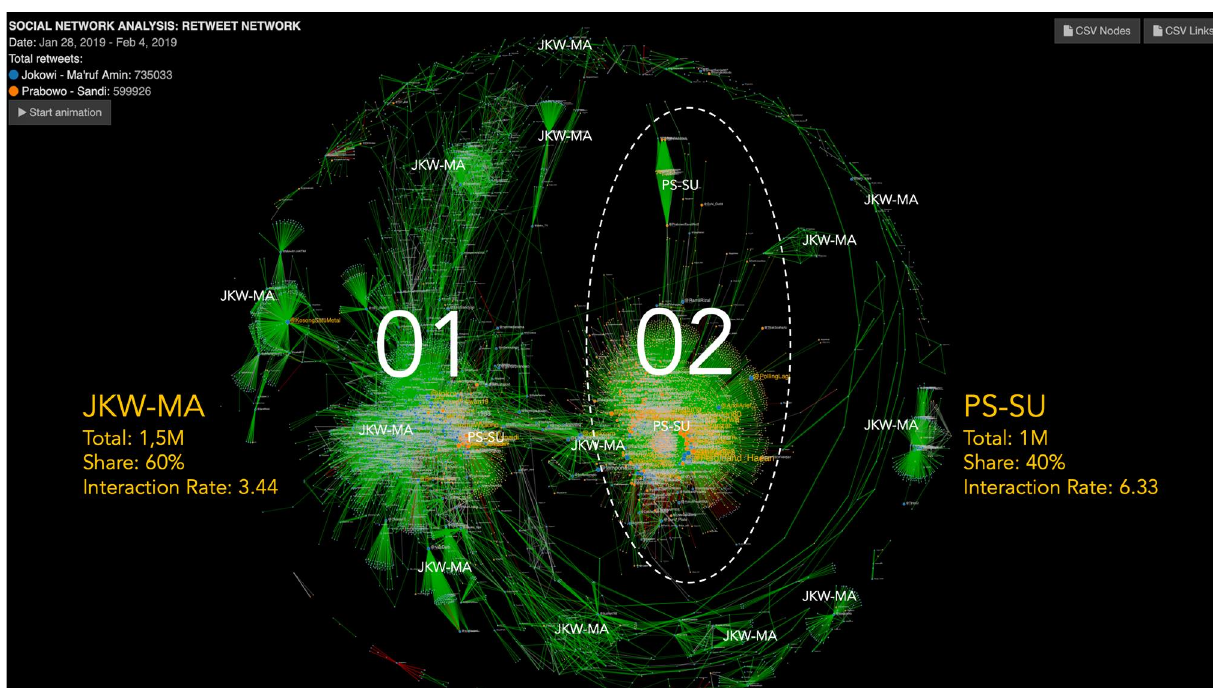
Figure 2. SNA map of netizens’ conversations on Twitter concerning the Presidential Election between the Number 01 pair of candidates (Jokowi-Ma’ruf Amin/JKW-MA) and the Number 02 pair of candidates (Prabowo-Sandiaga/PS-SU) on 28 January 2019 and 4 February 2019. Source: DEA